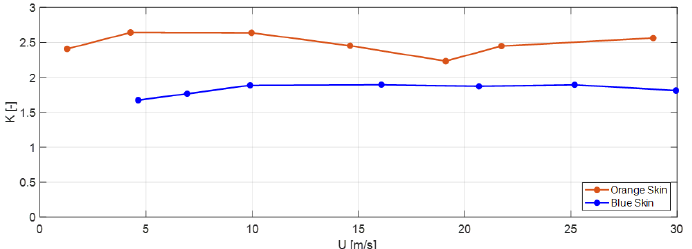
Figure 13. Pressure loss coefficient for the Orange and Blue